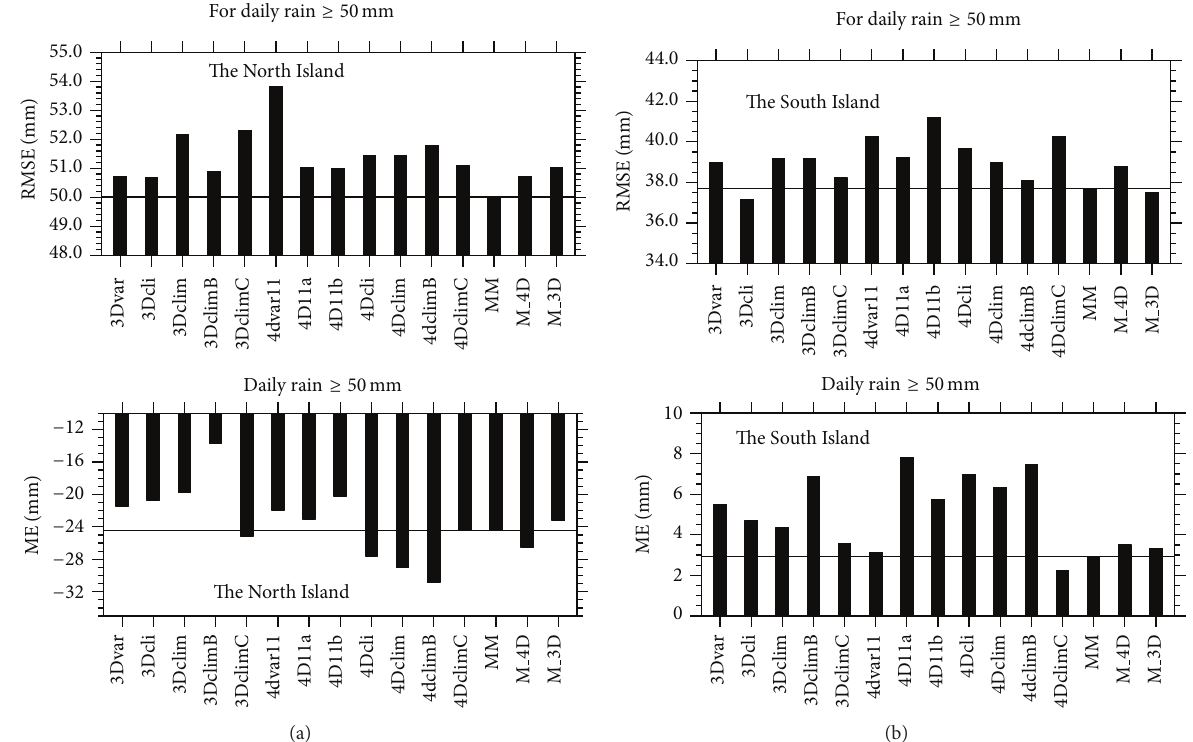
Figure 11: As in Figure 8 but for heavy rainfall over the North Island (a) and over the South Island (b).